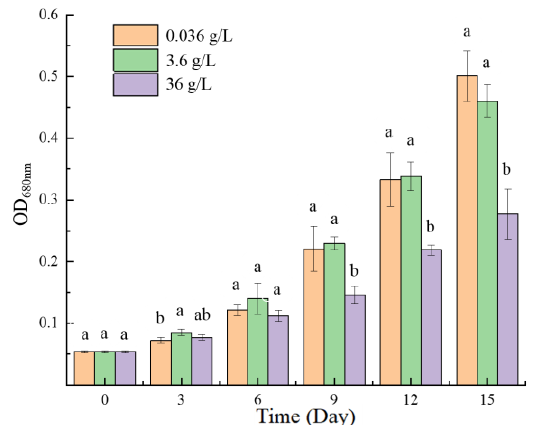
Figure 1. Effects of three concentrations of CaCl 2 on the growth of P. kessleri FACHB-3316. (The OD 680nm means the absorbance of the algal solution at 680 nm wavelength. The letters a and b indicate the significance of the